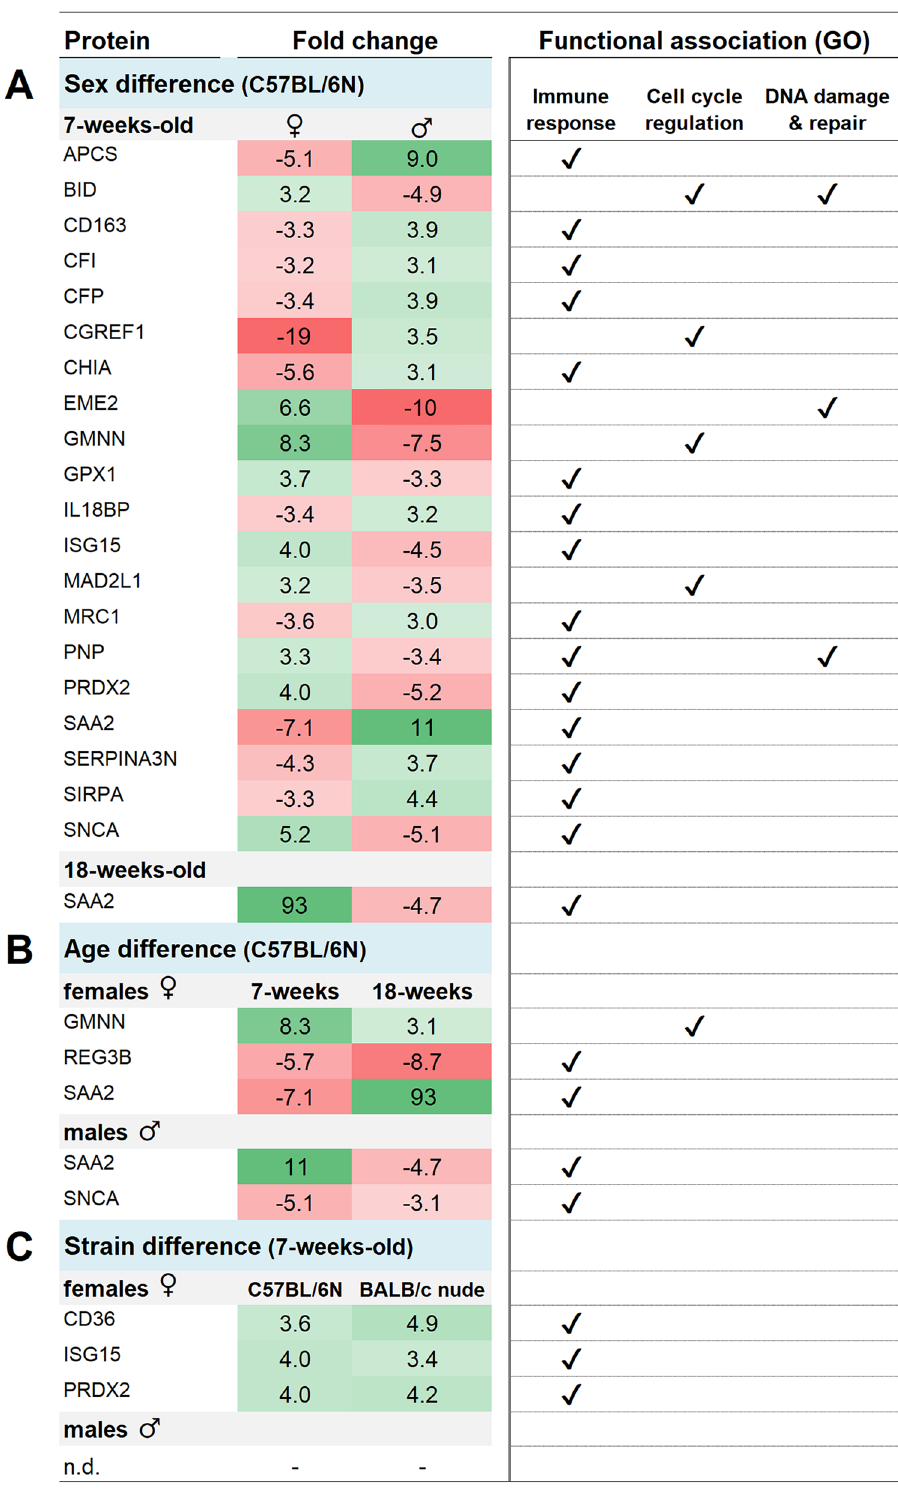
Figure 6. Panel of differentially abundant proteins shared between sex, age or strain in paired comparison. Proteins with differential abundance (|FC|≥ 3) in blood plasma 24 h after 0.5 Gy total body irradiation were associated with Gene Ontology terms (right-hand panel); selected radiation-induced responses are shown, i.e. immune response, cell cycle , and DNA damage and repair . Protein lists given as pairwise comparison between both sexes ( A ), both age groups ( B ), and both strains ( C ). ♀ , female; ♂ , male; n.d., none determined. Please note that presented data is normalized to respective unirradiated control